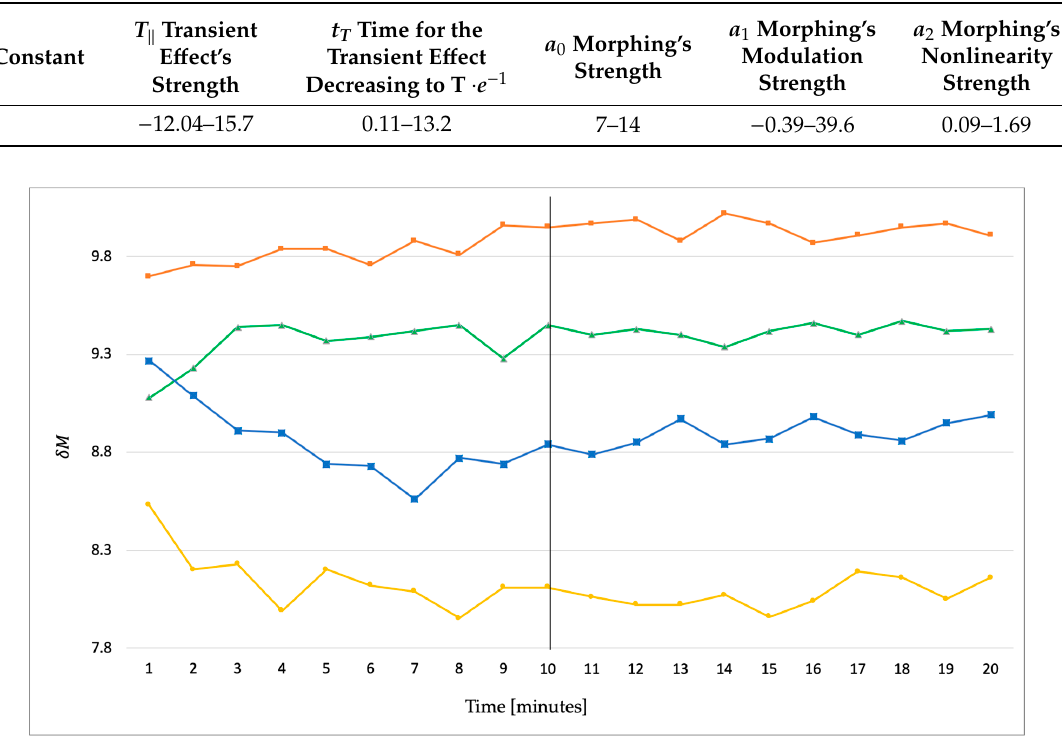
Table 2. Overview of Characteristic Constants.